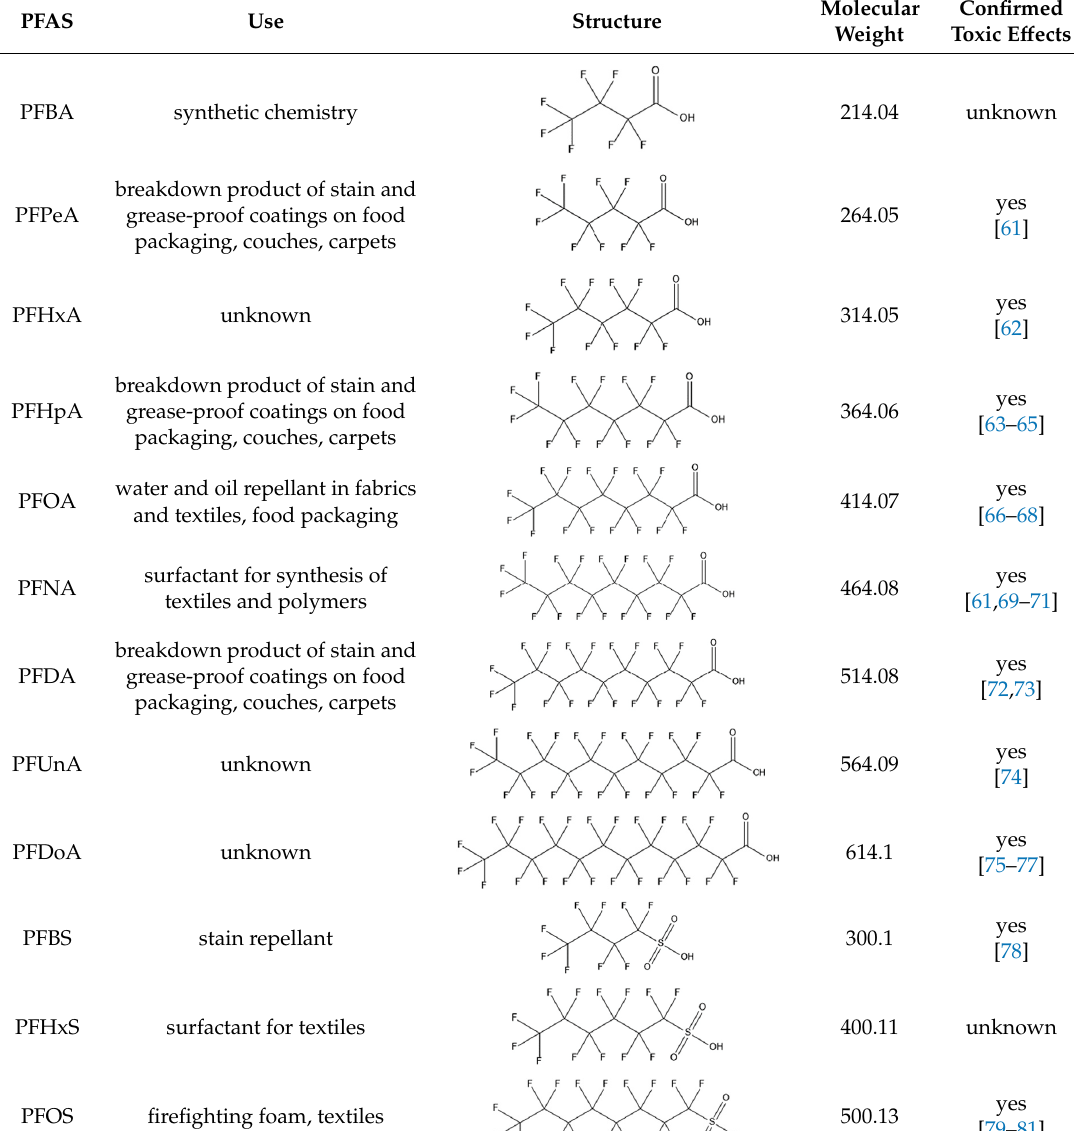
Table 1. A list of the most common perfluorinated substances (PFAS) with their applications and properties [31].